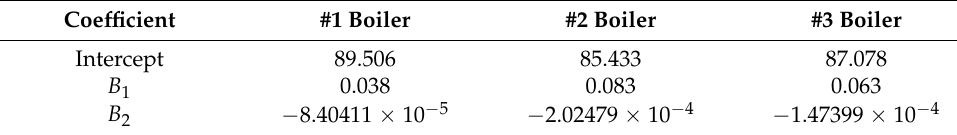
Table 6. Boiler load characteristic equation polynomial